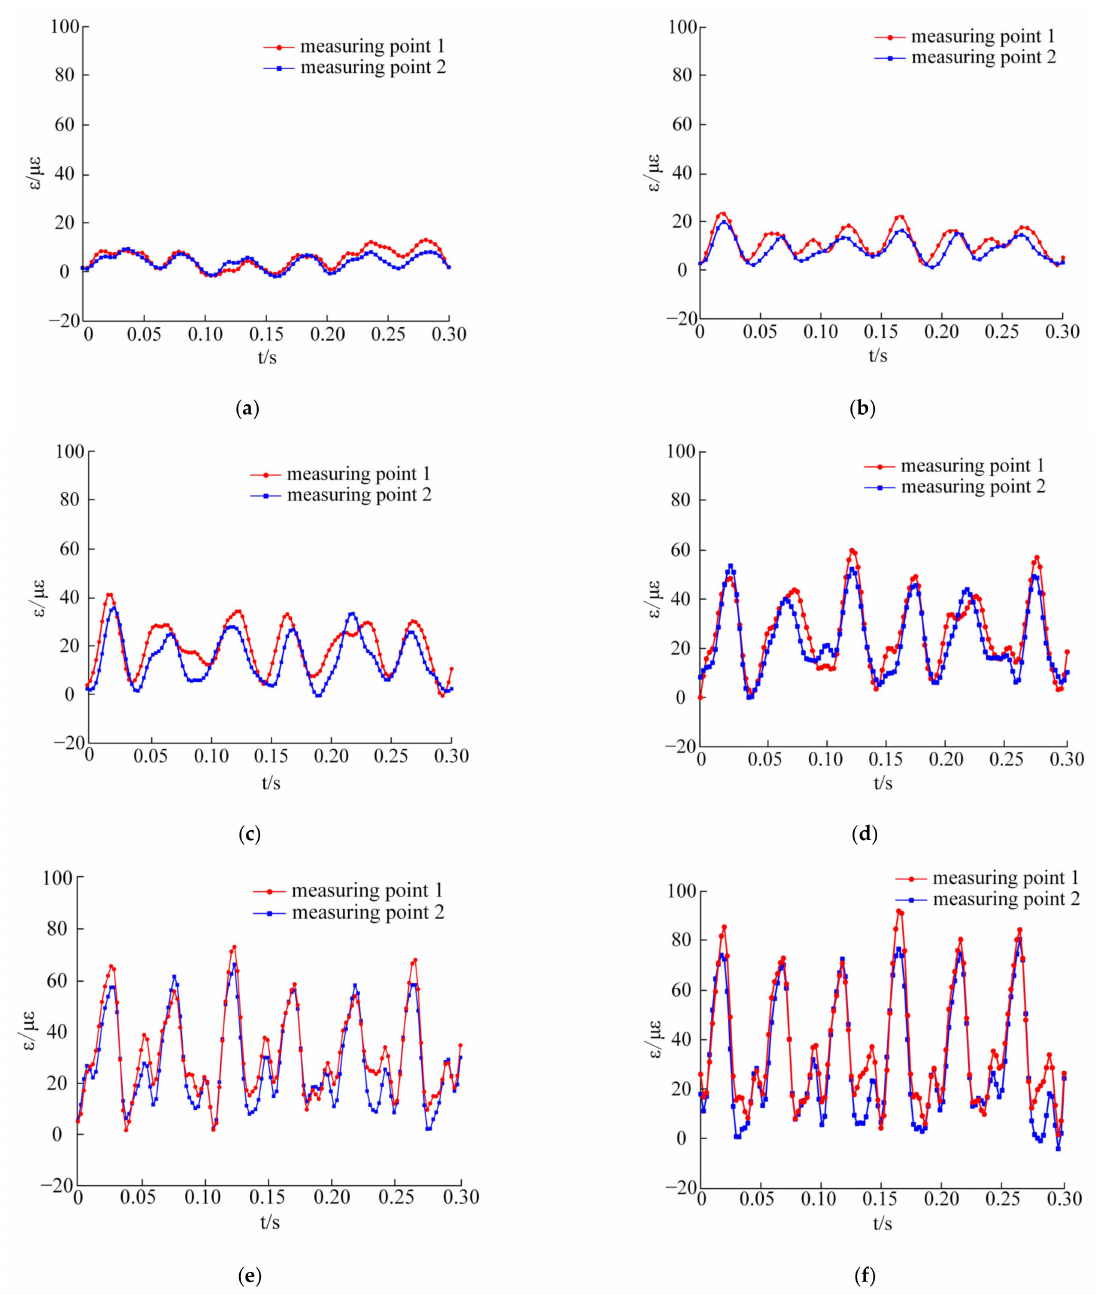
Figure 14. Strain curves under different loads: ( a ) Strain curves without load; ( b ) 2 N · m; ( c ) 4 N · m; ( d ) 6 N · m; ( e ) 8 N · m; ( f ) 10 N ·